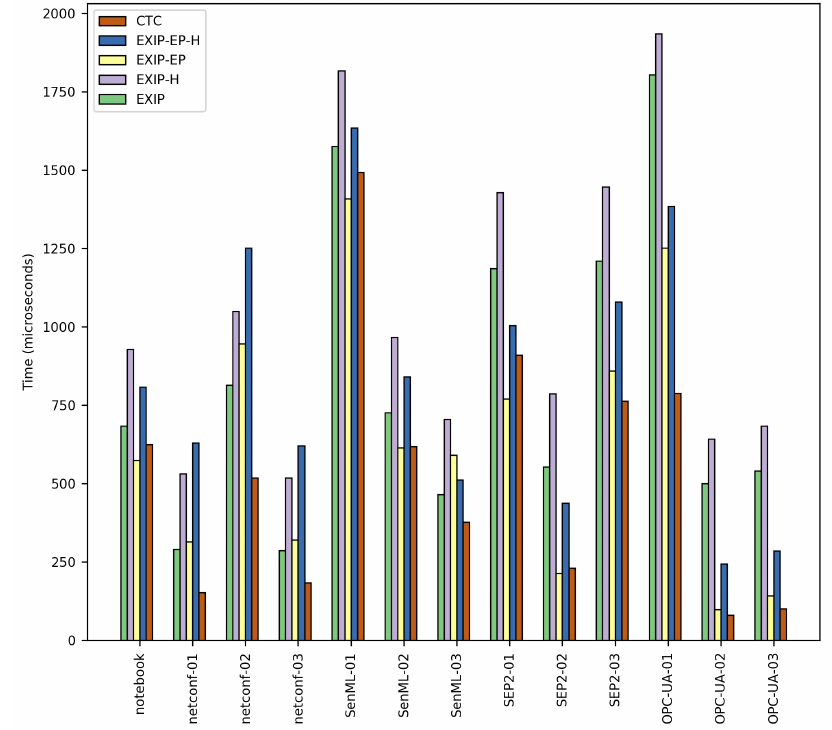
Figure 11. XML document decoding time comparative. EXIP : schema strict mode, all preserve options to F ALSE and schemaId to constant string “1”. EXIP-H : same options as EXIP column and EXI options embedded in the EXI header. EXIP-EP : same options as EXIP column plus EXI Profile. EXIP-EP-H : same options as EXIP-EP column and EXI options embedded in the EXI header but no EXI Profile parameters. CTC : CTC normal and strict modes.